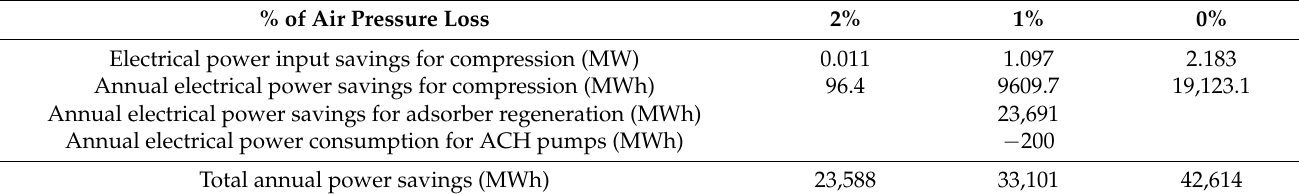
Table 14. Total annual power savings calculation resulting from ACH implementation.